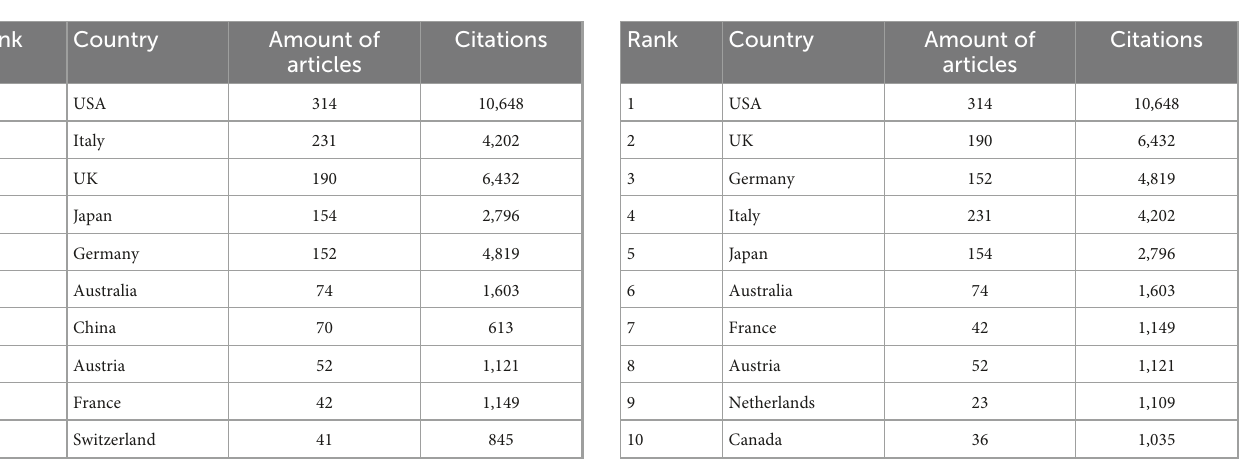
frequency. Geographic distribution is visualized in Figure 5